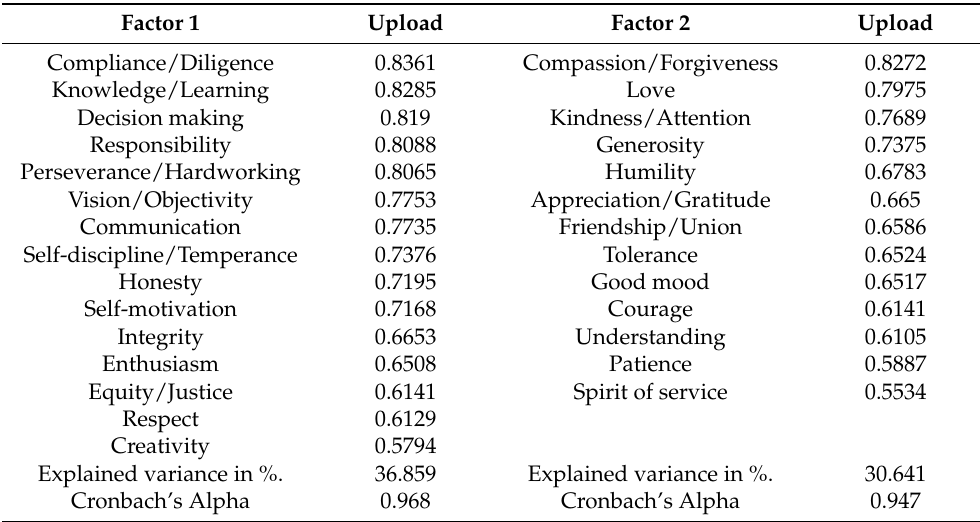
Table 10. Composition of factors of the ethical values present in teamwork.